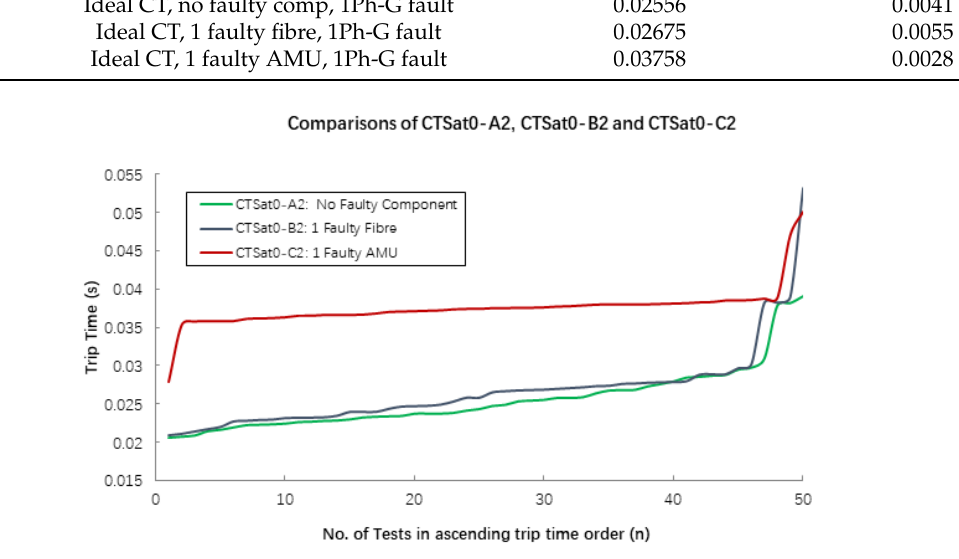
Figure 15. Comparisons for CTSat0-A2, CTSat0-B2 and CTSat0-C2 (ideal CT, no/one faulty compo- nent, 1Ph-G fault at 70% of the feeder).